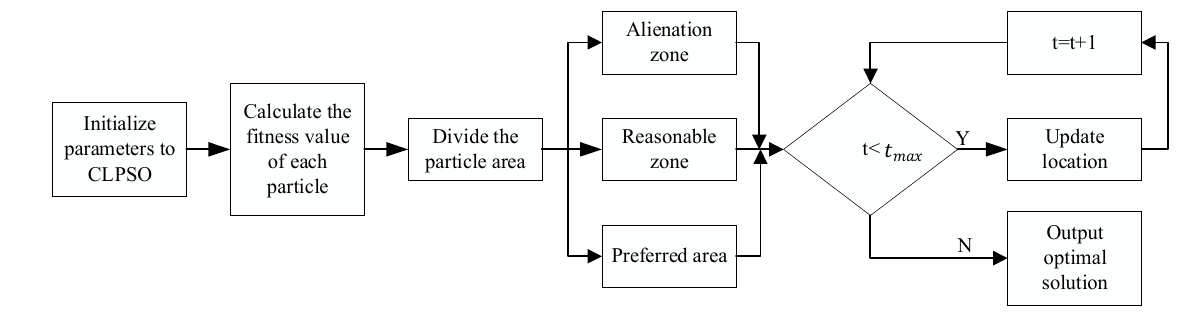
Figure 4. CLPSO algorithm flow chart.